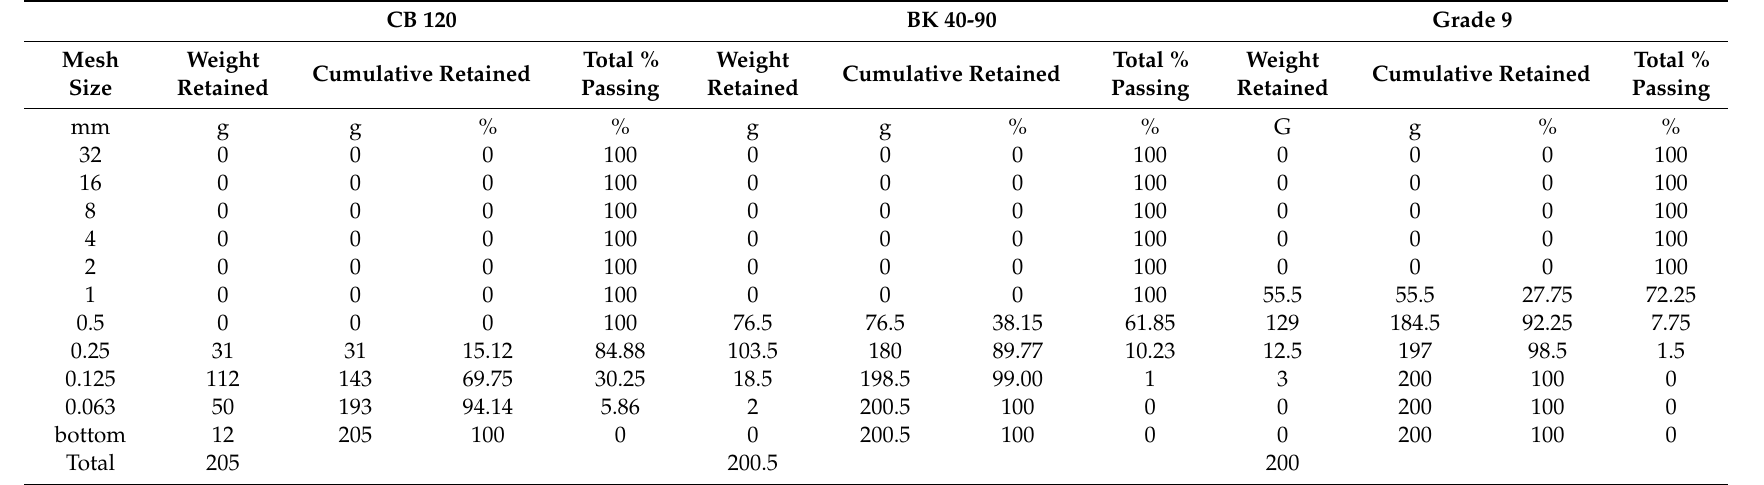
Table 2. Weight values retained (g), cumulative retained (%), and passed of di ff erent particles CB 120, BK 40-90 and Grade